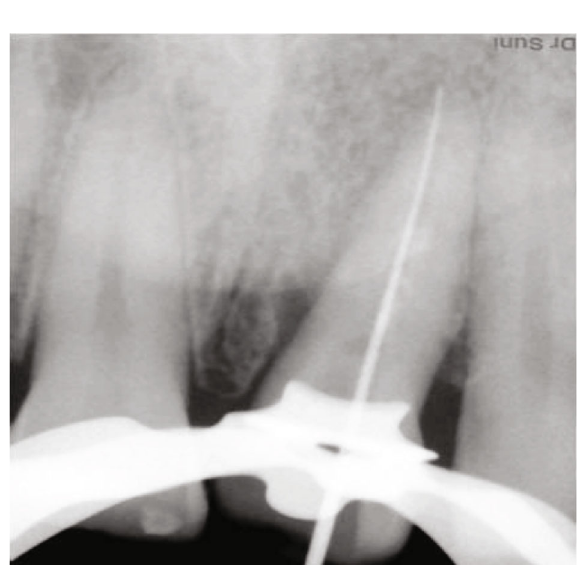
Figure 3: Working length determined.